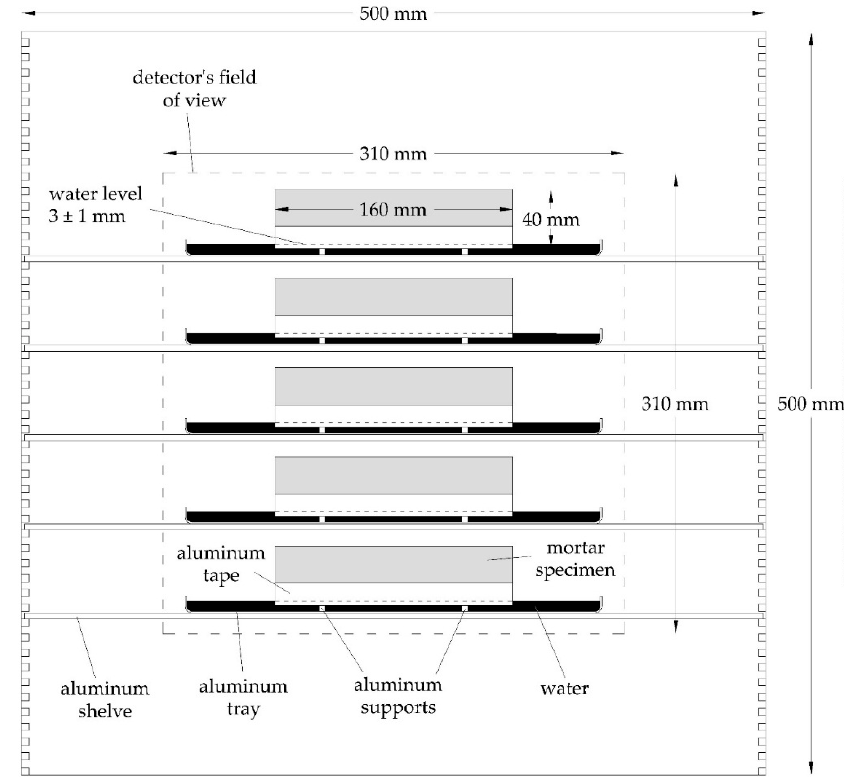
Figure 3. Setup of the samples in the aluminum test frame during scanning.